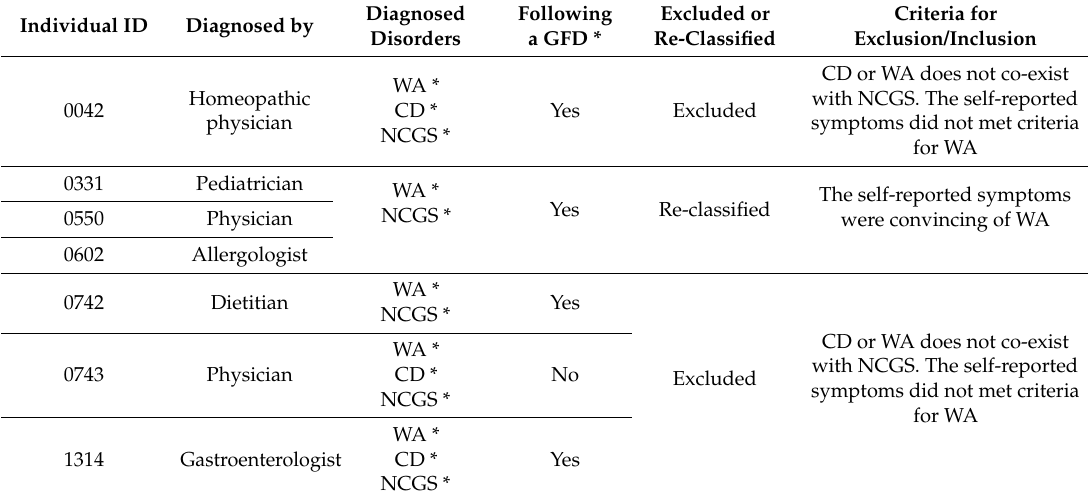
Figure 2. Gluten-free diet (GFD) adherence and avoiding of wheat/gluten according to age. ** p < 0.01